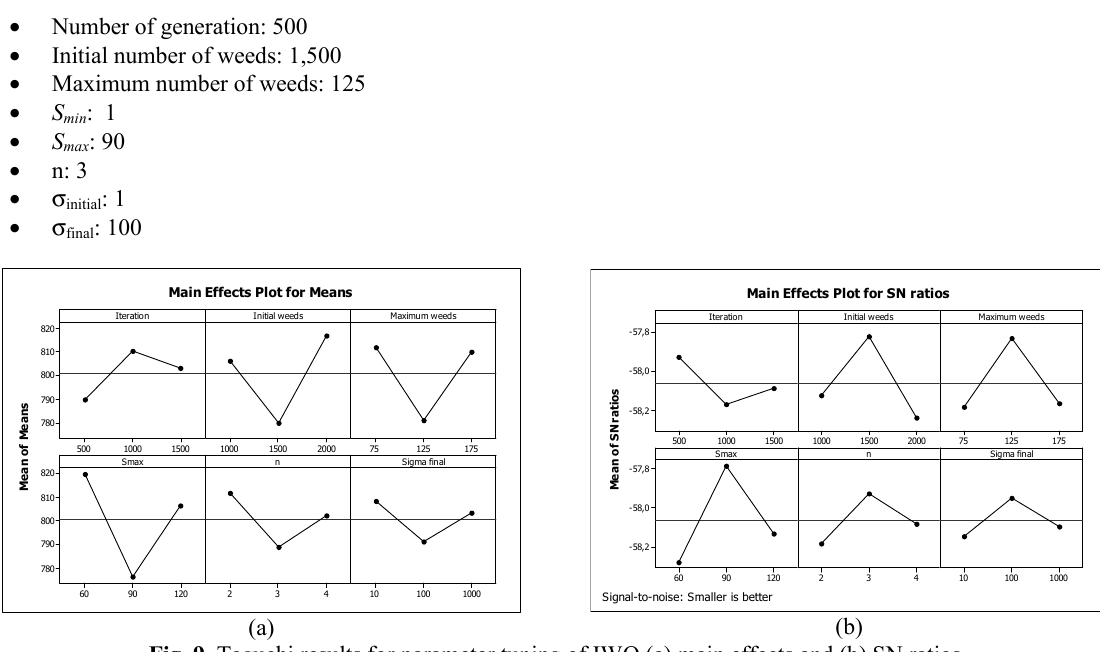
Fig. 9. Taguchi results for parameter tuning of IWO (a) main effects and (b) SN